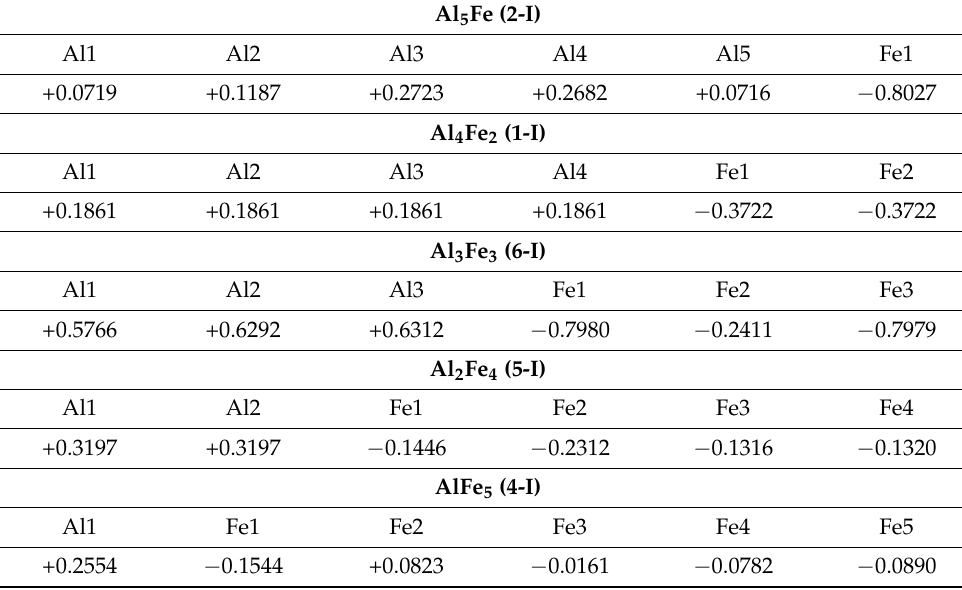
Table 12. Charge distribution (in units of electron charge) of various Al and Fe atoms for the most stable Al n Fe m metal clusters (n + m = 6) according to NBO analysis